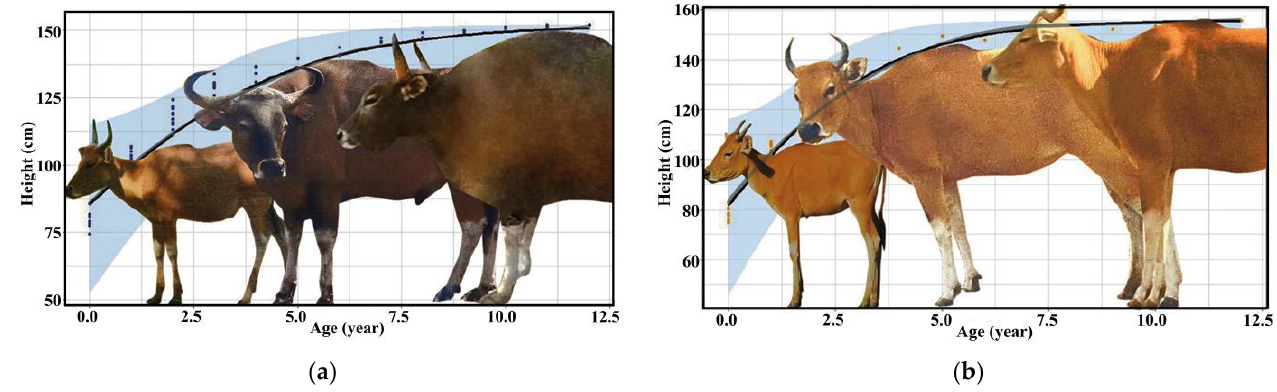
Figure 1. Development of morphology and height of ( a ) male and ( b ) female banteng in captivity.